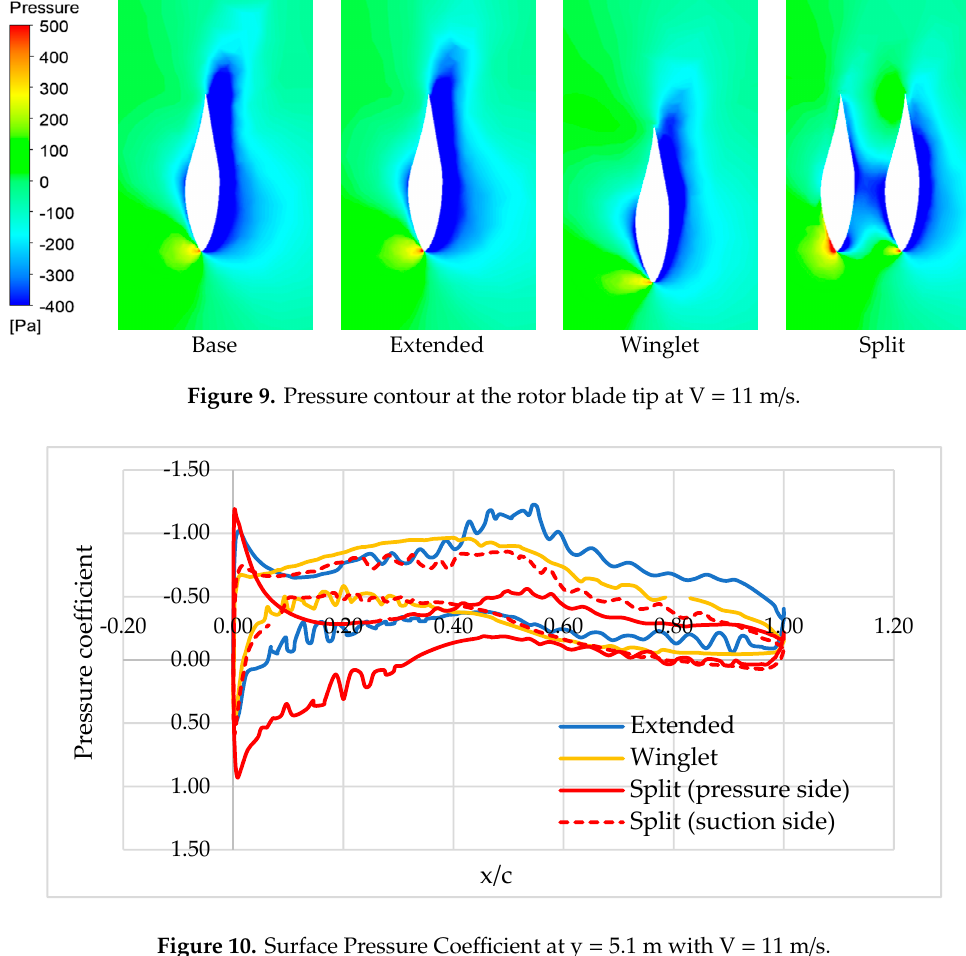
Figure 10. Surface Pressure Coefficient at y = 5.1 m with V = 11 m/s.